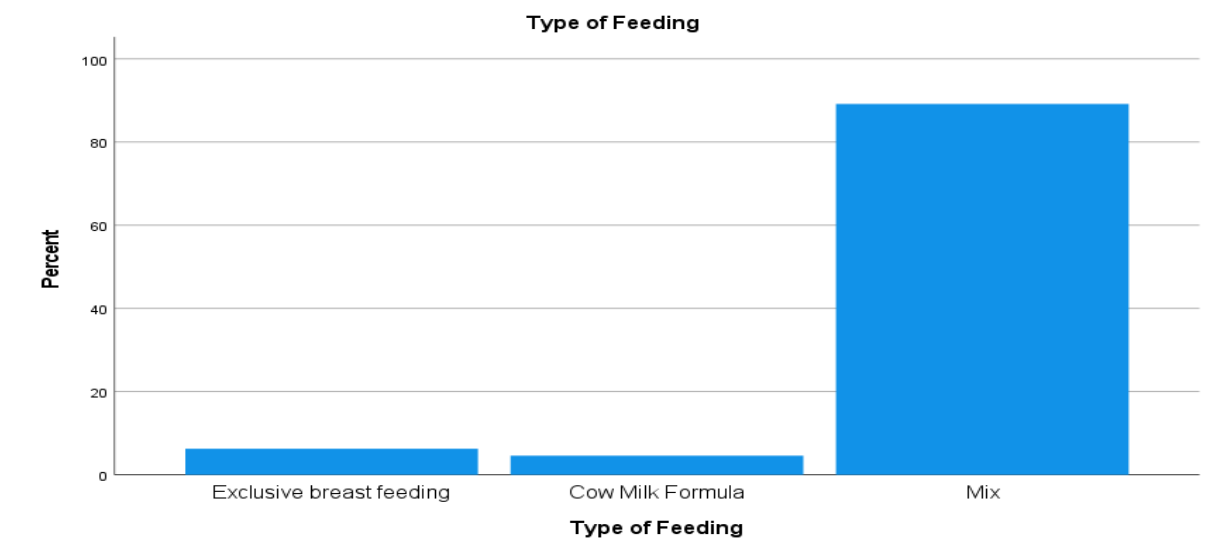
Figure 1. Types of feeding.